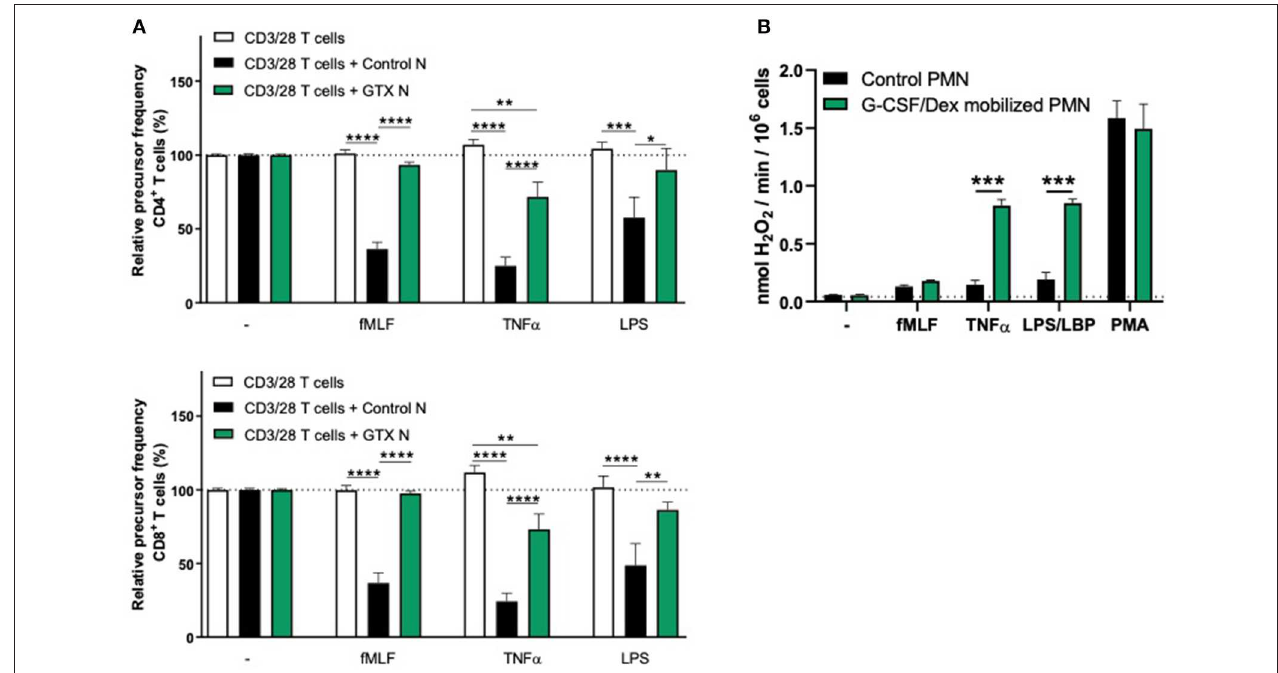
FIGURE 2 | G-CSF/Dex-mobilized neutrophils cannot suppress T cell proliferation despite normal/increased ROS production. (A) Purified CFSE-labeled T cells from healthy donors ( n = 4) were cultured in absence (white bars) or presence of mature neutrophils from control donors (black bars, n = 4), or G-CSF/Dex-mobilized neutrophils (green bars, n = 3). T cells were stimulated with anti-CD3 and anti-CD28 antibodies. Neutrophils were kept unstimulated or activated with the indicated stimuli. After 4 or 5 days, cells were harvested and analyzed by flow cytometry for CFSE dilution among CD4 + (upper graph) and CD8 + (lower graph) T cells. Error bars indicate SEM; the statistical analysis one-way ANOVA was used. (B) G-CSF/Dex-mobilized neutrophils or control neutrophils were stimulated with the indicated stimuli and production of H 2 O 2 was determined by measuring Amplex Red conversion into fluorescent Resorufin ( n = 3–4). Error bars indicate SEM; the statistical analysis unpaired two-tailed t- test was used. * p < 0.05, ** p < 0.01, *** p < 0.001, **** p <